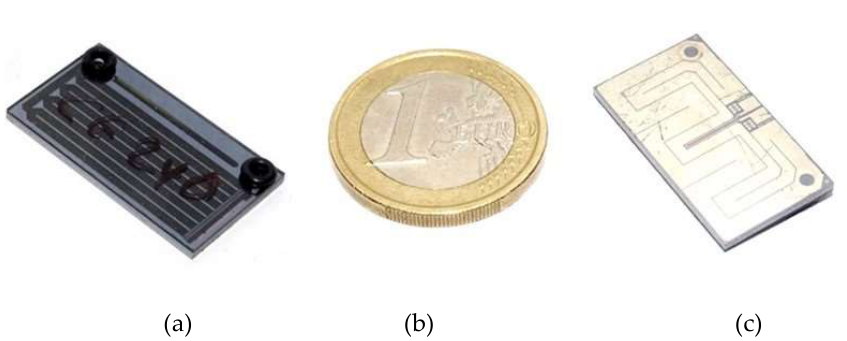
Figure 2. MEMS pre-concentration cartridge. ( a ) bottom view, ( b ) 1 euro coin for size comparison, ( c ) top view.